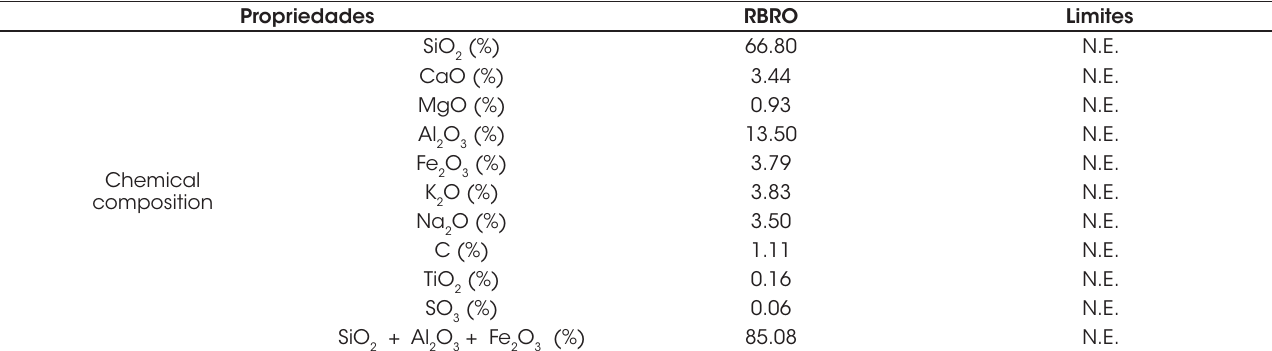
Table 3 OSR chemical composition